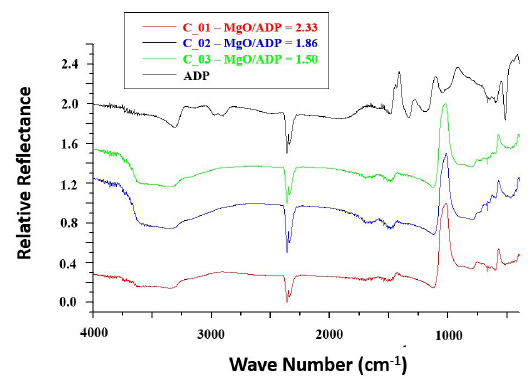
Figure 6. X-ray diffractograms of composition C_01, prepared from MgO powders calcined at 1100 °C / 2 h, with different ages, after setting (Phases: + struvite; * dittmarite; o MgO).